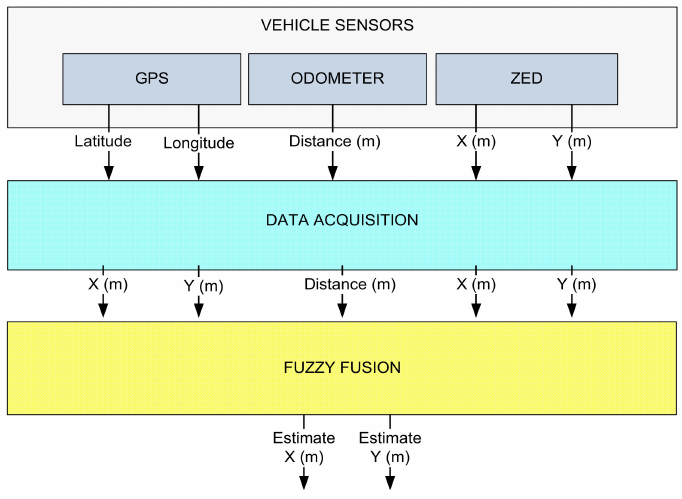
Figure 3. Methodology’s flow